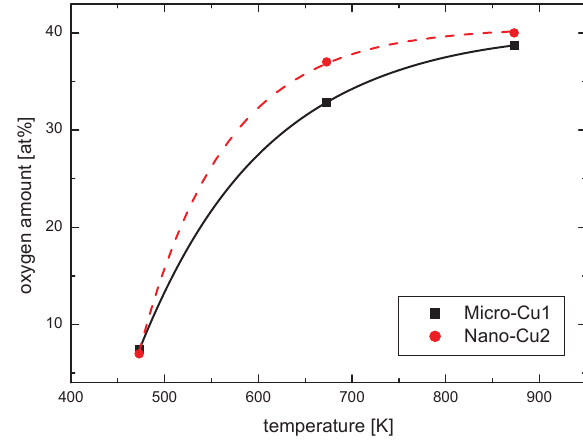
Figure 7. Concentration of oxygen (in atomic %) on the surfaces of both materials tested at various elevated tem-